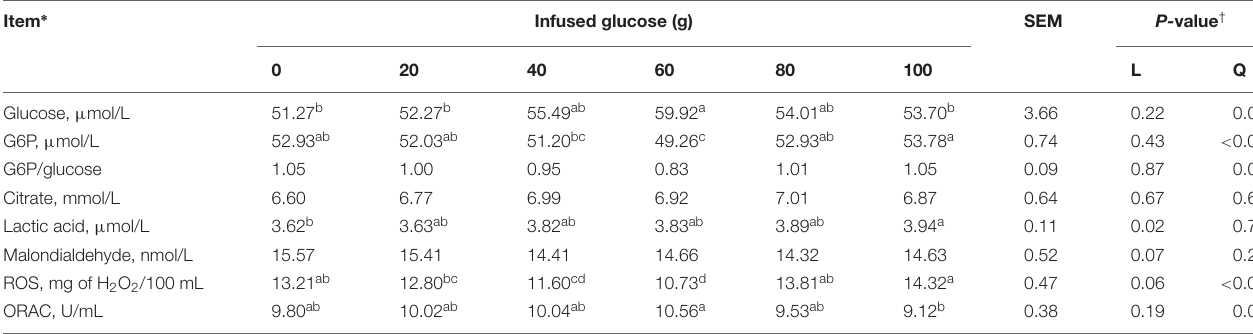
glucose is quickly distributed and absorbed among